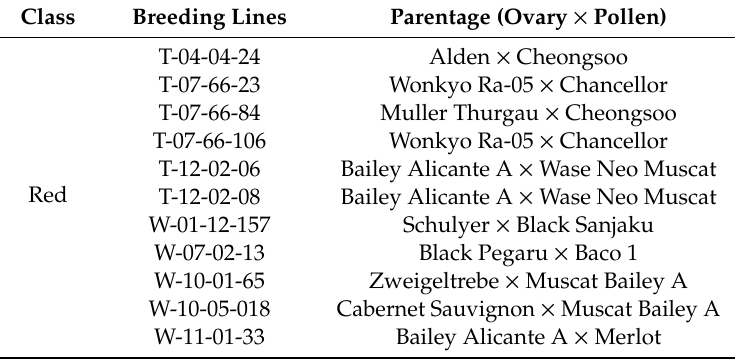
Table 1. List of grape breeding lines and their